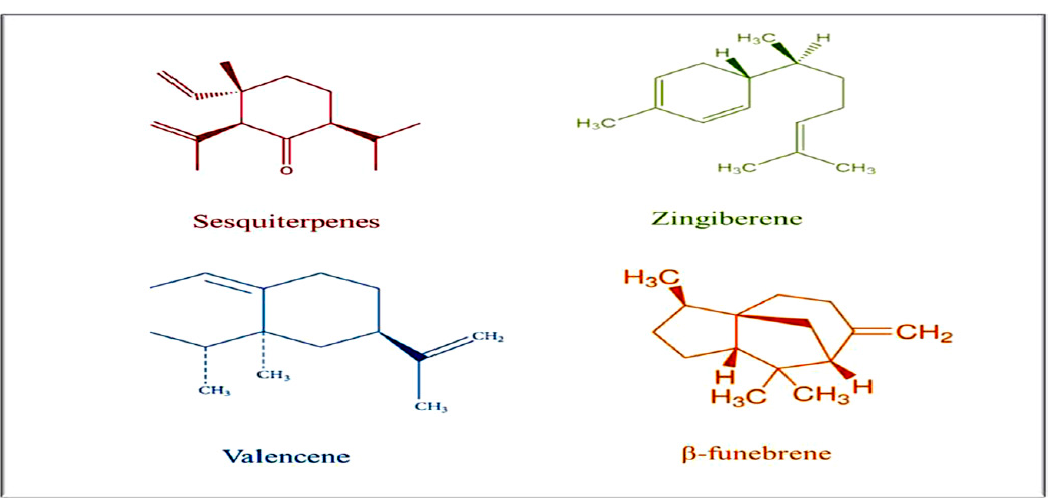
Figure 2. The major sesquiterpene components.